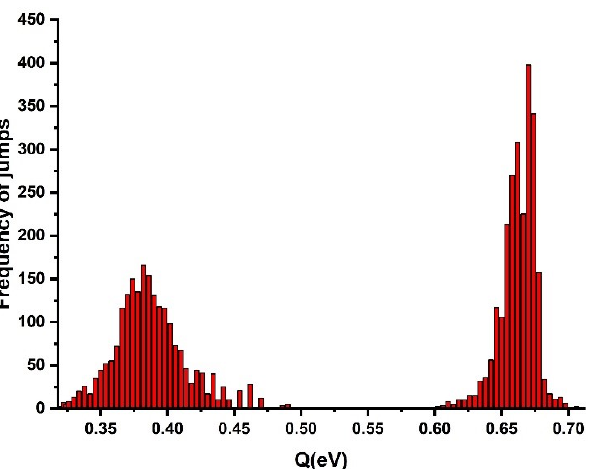
Figure 5. The amorphous and crystalline activation energy distributions, in which the first peak shows the mean value of the activation energy of the amorphous phase (0.38 eV) and the second peak shows the mean value of the activation energy of the crystalline phase (0.66 eV).